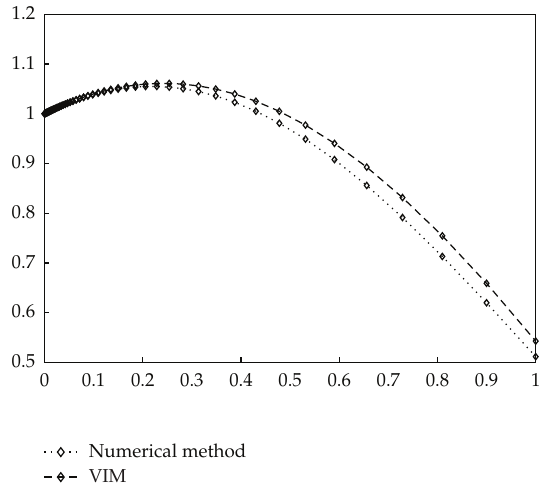
Figure 1: Time response for x ΔΔ (cid:10) (cid:7) 0 . 1 (cid:10) 0 . 1 x (cid:8) x Δ (cid:10) x (cid:10) x 2 (cid:6) 0 with 3 iterations.